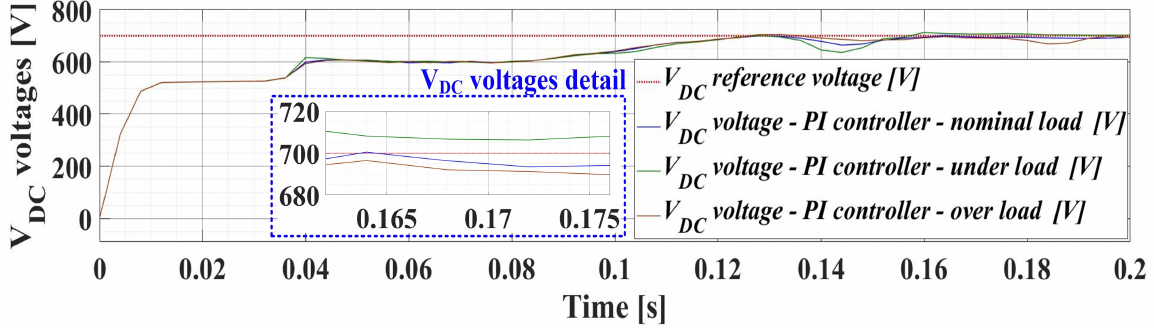
Figure 8. V DC voltages time evolution of the UPQC-APF control system based on PI controller in case of nonlinear load.